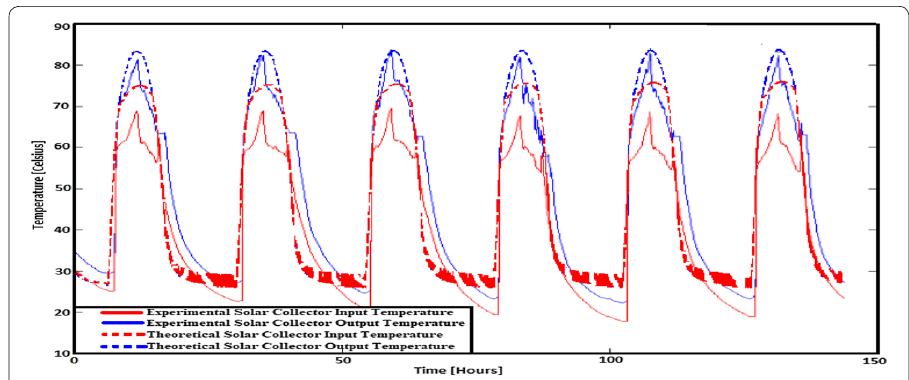
Fig. 6 Model validation: comparison of measured and calculated collector outlet